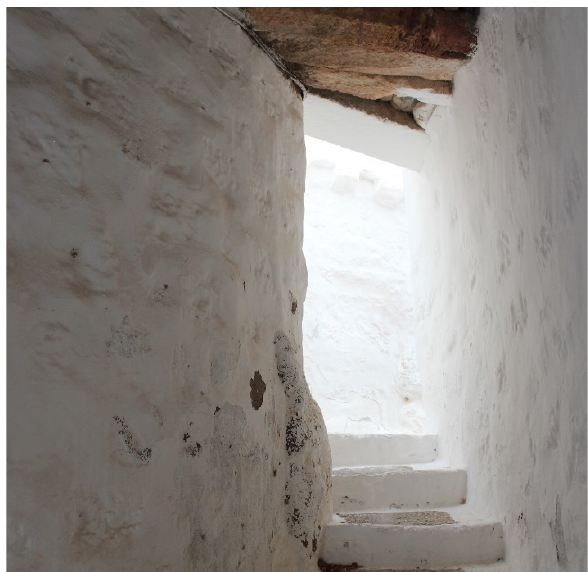
Figure 3. Narrow and covered passages of Chorá.